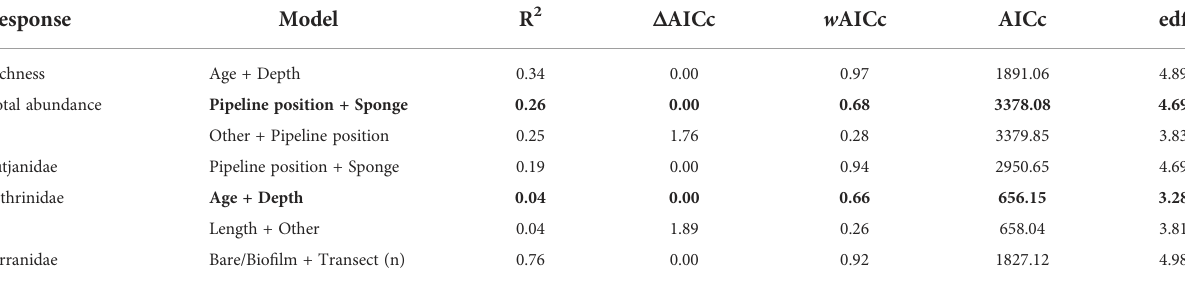
TABLE 7 Generalised additive models (GAMs) for predicting total fi shery target species abundance, fi shery target species richness, and the total abundance of Lutjanidae, Lethrinidae, and Serranidae observed on pipelines in depths <400 m in the north-west, within 2 Akaike information criterion of the top